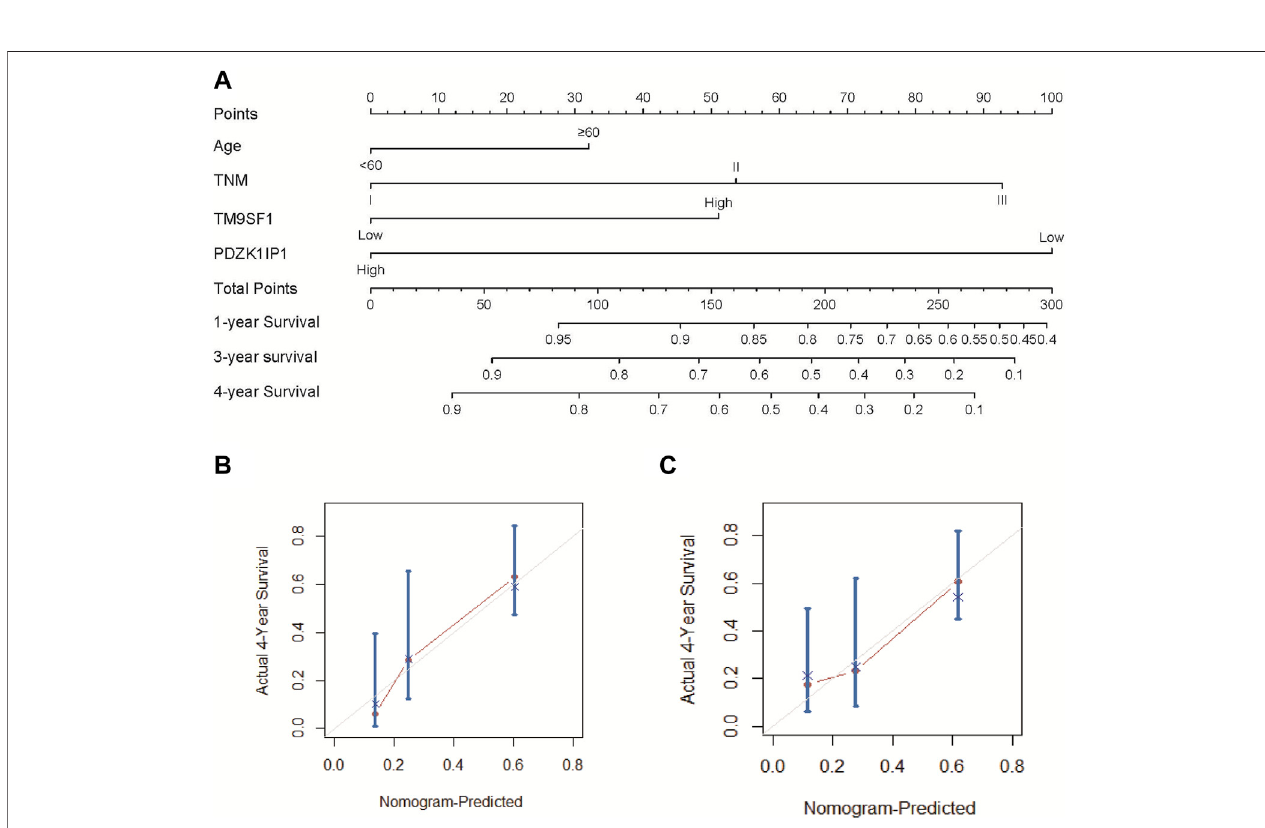
FIGURE5 | Nomogram and calibration curve ofESCC patients. (A) To usethe nomogram, each variable hasa patient ’ sassignmenton its axis, and alineisdrawn upwardtodeterminethenumberofpointsforeachvariable ’ svalue.Thesumofthesepointsislocatedonthetotalpointsaxis,andthenaperpendicularlineisthendrawn downwards tothe survival axis to determine the 1-year, 3-year, and 4-year OS probability. (B) The calibration curve for the prediction of 4-year OSbased on the internal validation cohort. (C) The calibration curve for the prediction of 4-year OS based on the external validation two cohort. In (B) and (C) , the OS prediction of nomogram probability is plotted on the x -axis, and the real OS is plotted on the y -axis.